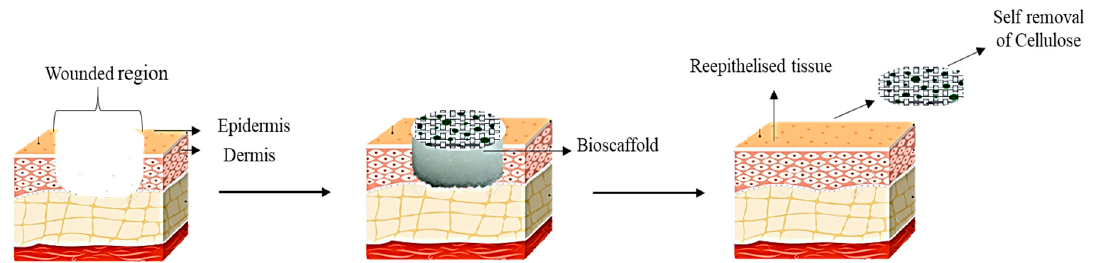
Figure 5. Mechanism of action of cellulose/collagen in ulcerated region.